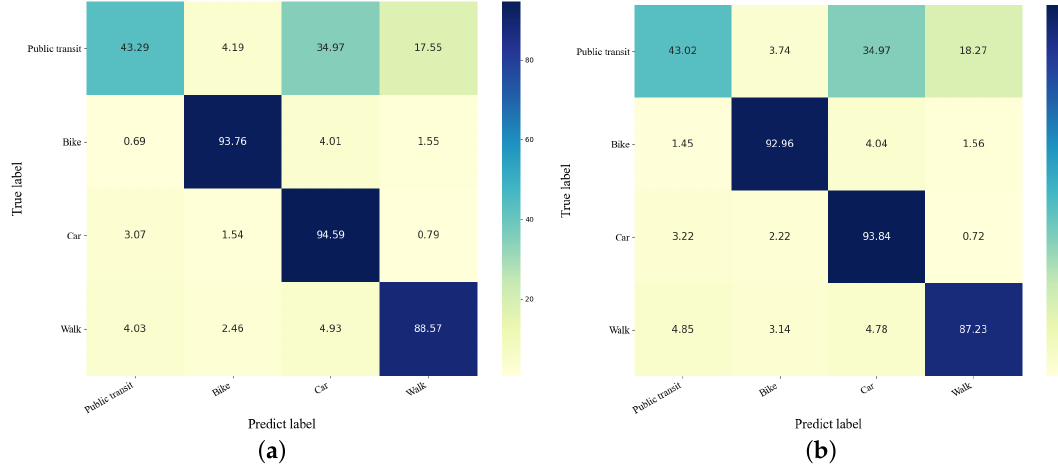
Figure 8. The confusion matrix of the MTL Trajet 2017 dataset. ( a ) Motion+GIS. ( b ) Motion.